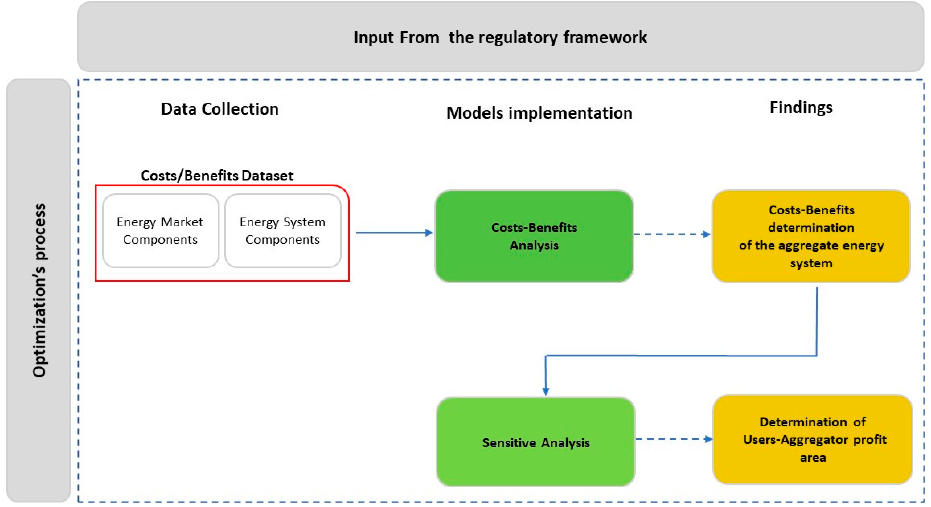
Figure 3. Methodology scheme.